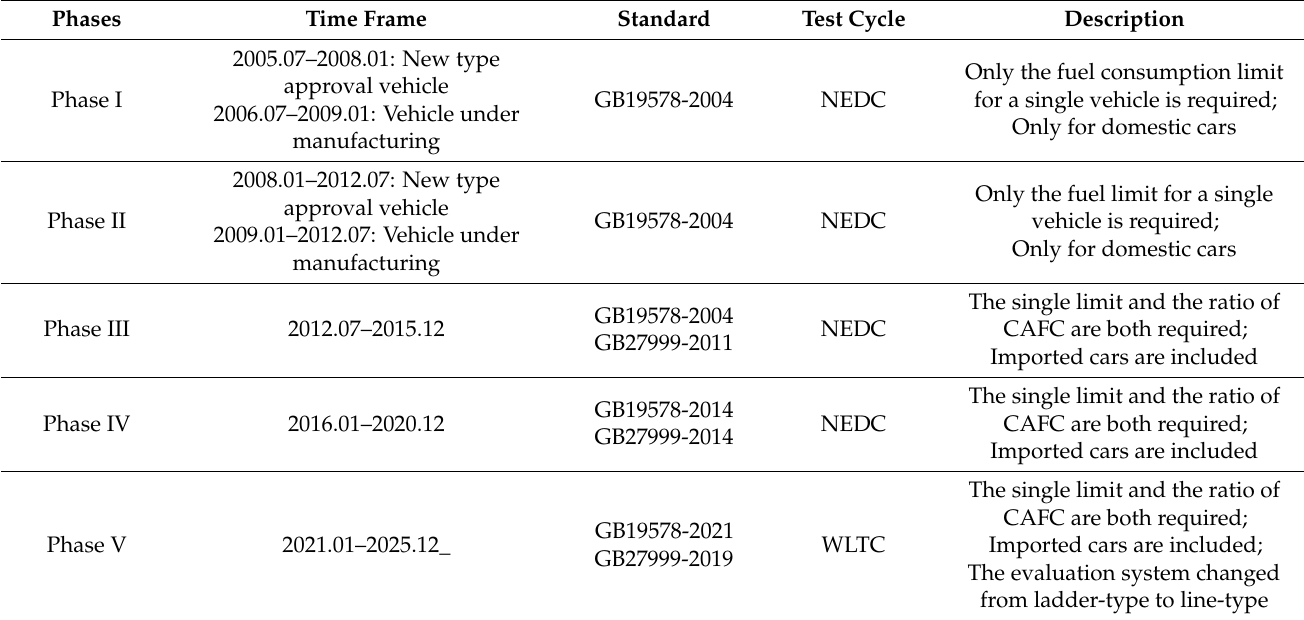
Table 1. Phases of China’s passenger vehicle fuel consumption regulations